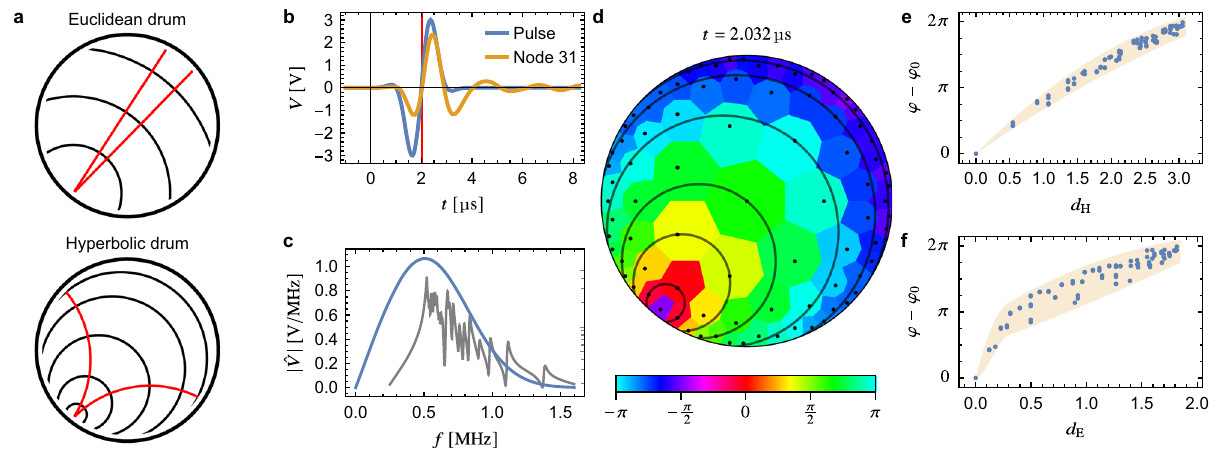
(cid:4) (cid:4) (cid:4) (cid:4) (gray; shown on a loga- pulse by comparison to the impedance to ground Z 31 rithmic scale on the right axis from 20 to 500 Ω ). d Instantaneous phases of the pulse propagating on the hyperbolic drum (see legend) at time t =2.032 μ s. The nodes are indicatedby blackdots, and concentric hyperboliccircles with center at node 31 are shown in black to illustrate the hyperbolic metric. e Difference of the instantaneousphase φ ateachnodetotheoneatthesourceofthesignal(node31) d φ 0 vs. the hyperbolic distance H to the source. f Difference of the instantaneous phase φ at each node to the one at the source of the signal (node 31) φ 0 vs. the Euclidean distance d E to the the source. The shaded region in e , f indicates the approximate spread of the instantaneous phase as a function of d H and d E ,